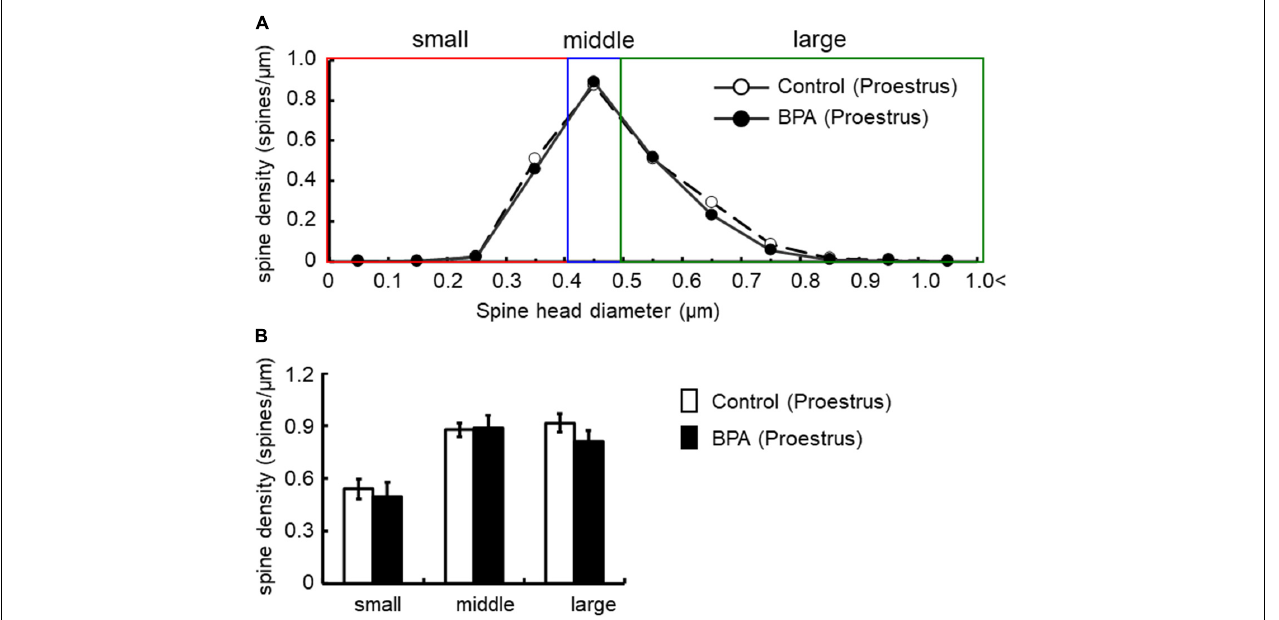
FIGURE 4 | Changes in the density of spines in the hippocampus of grownup female rats at proestrus stage by perinatal BPA exposure. (A) Histogram of spine-head diameters without BPA (control, open circle) or with BPA (BPA, filled circle) in female rats at proestrus stage, respectively. (B) Density of three subtypes of spines, from left to right: small-, middle-, large-head spines. Results are represented as mean ± SEM. In each group, the white and black columns are expressed for the control and BPA-treated data, respectively. We investigated 3 rats, 7 slices, 13 neurons, 26 dendrites, ∼ 3000 spines for female proestrus control and 4 rats, 8 slices, 16 neurons, 32 dendrites, ∼ 3500 spines for female proestrus BPA. The significance of the BPA effects was confirmed via statistical analysis using t -tests.